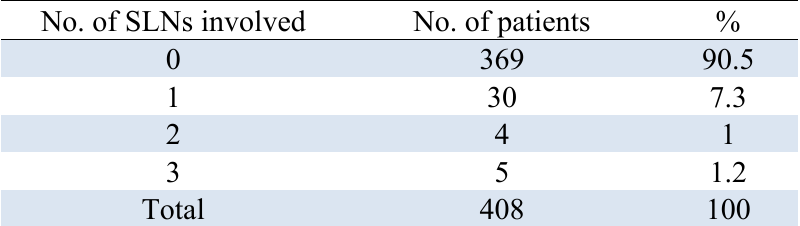
Table 3. The number of SLNs